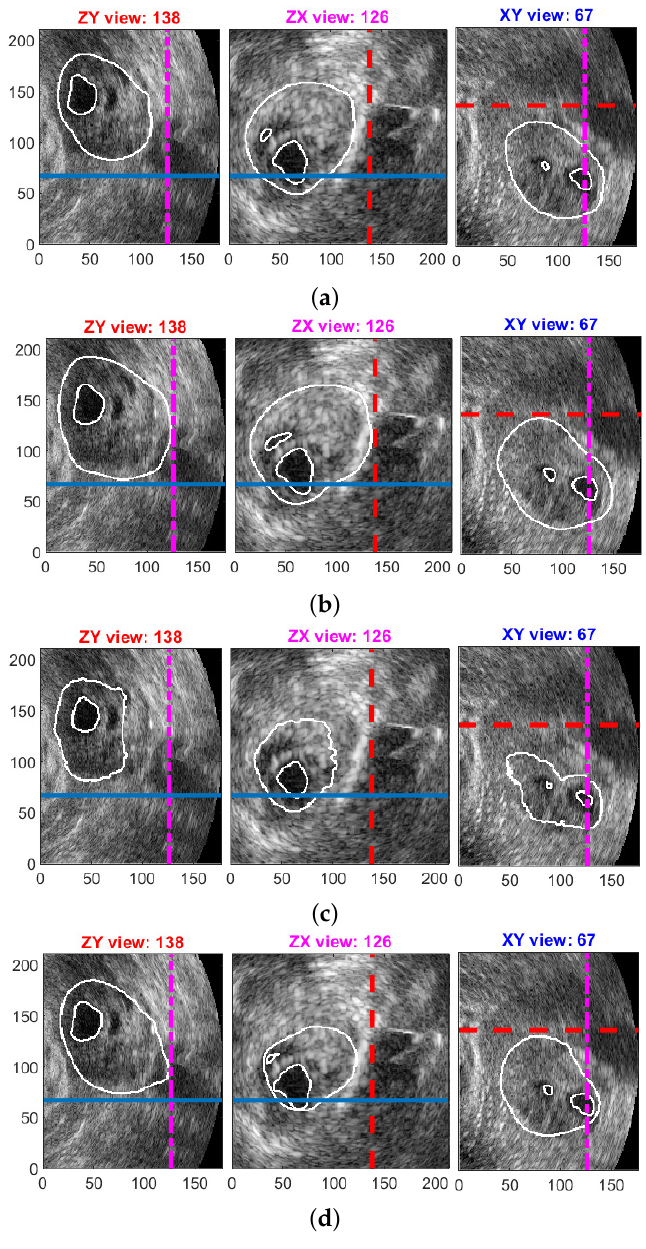
Figure 8. Qualitative results for the better compared methods. Detected follicles and ovary are superimposed on the selected cross-sections: ( a ) ‘EXT 1 + DS (best)’ method; ( b ) ‘EXT 2 + DS (last)’ method; ( c ) ‘SNET (best)’ method; ( d ) ‘3D UNET + DS (best)’ method. Rater’s annotations are shown in Figure